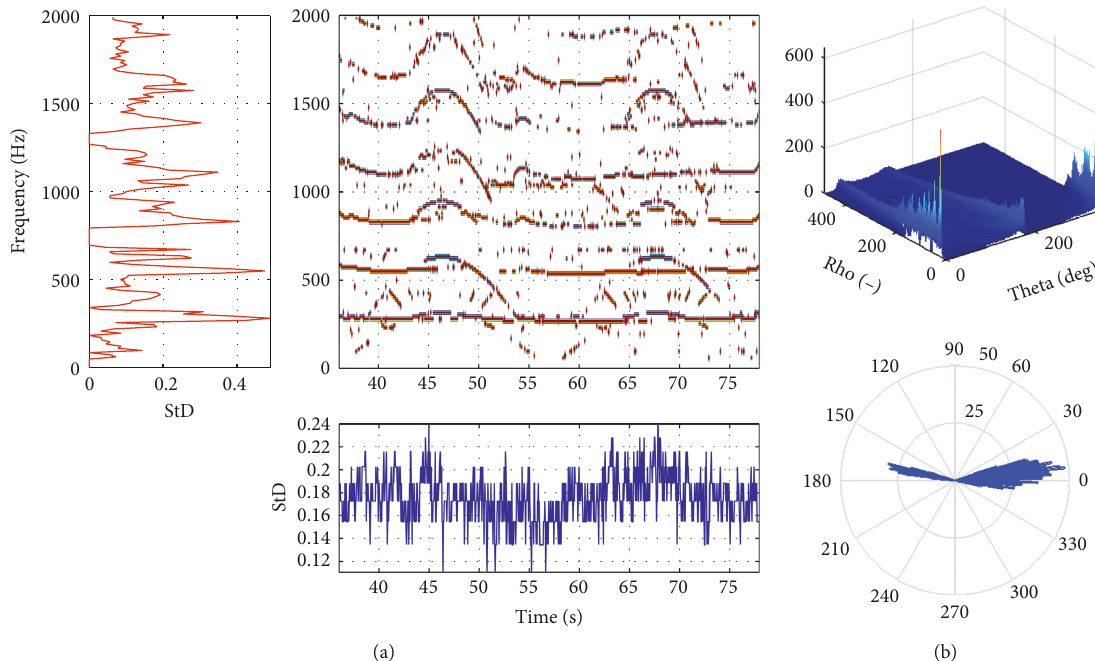
Figure 11: Time-frequency standard deviations (a) and HTdiagram with relevant theta’s polar histogram (b) of the peaks diagram (cropped within effective milling time range) of bed frame acceleration, for the second case of circular shape.